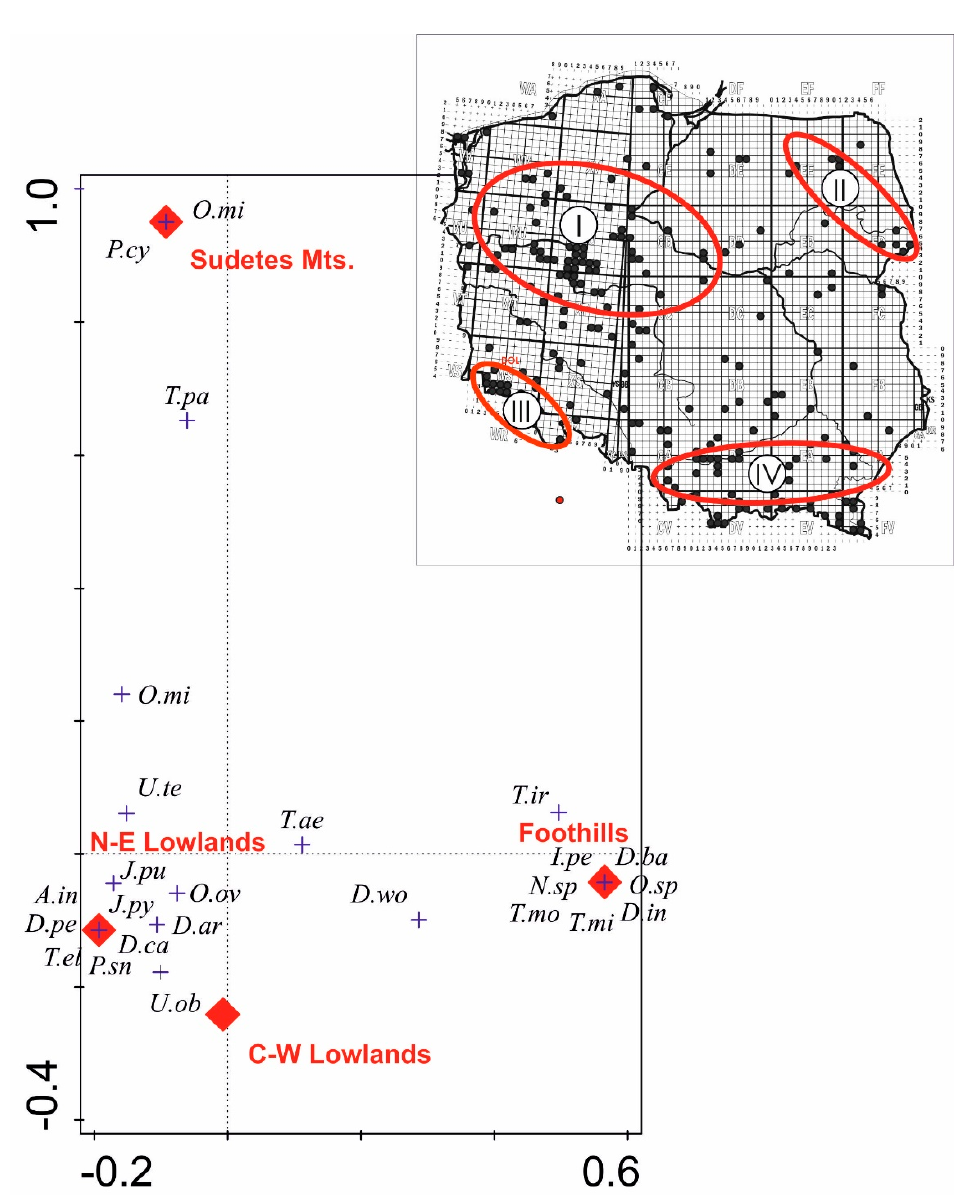
Figure A1. Canonical Correspondence Analysis (CCA) scatterplot showing the relationships between examined Uropodina mite communities from spruce from different regions of Poland from 53 samples from the Sudetes (III), 22 from Carpathians foothills (IV), 67 from north-eastern Poland (II) and 19 from central-western lowlands (I) on the first two axes. First and second axis explained 6.54% of variation (pseudo-F = 2.1, p = 0.020). Abbreviations of species are included in Section 2.